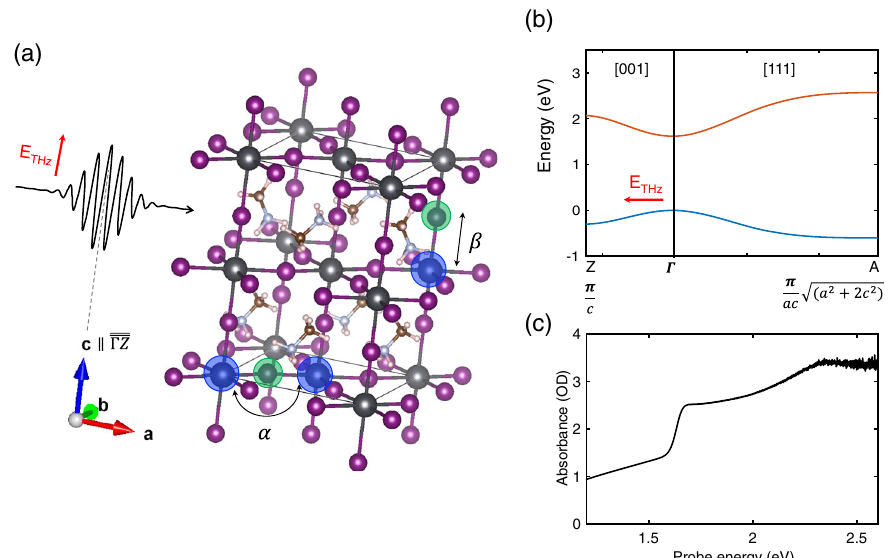
Fig. 1 Experimental scheme and properties of MAPbI 3 perovskite. a THz pulse geometry with a tetragonal unit cell (black rectangular cuboid) of MAPbI 3 (dark gray: Pb, purple: I, brown: C, light blue: N, light pink: H). The THz biasing along the c axis (parallel to the Γ Z direction) of a crystallite is depicted. The Pb-I-Pb angle along the diagonal direction of the a and b axis is denoted as α , and the Pb-I bond lengths along the c axis is denoted as β . b Simpli fi ed electronic band structure of MAPbI 3 in the tetragonal phase along the directions Γ (0,0,0) → Z(0,0,0.5) and Γ (0,0,0) → A(0.5,0.5,0.5). The bandwidths and the lattice parameters are used from ref. 24 . c Optical absorption spectrum of MAPbI 3 in the spectral range of the probe